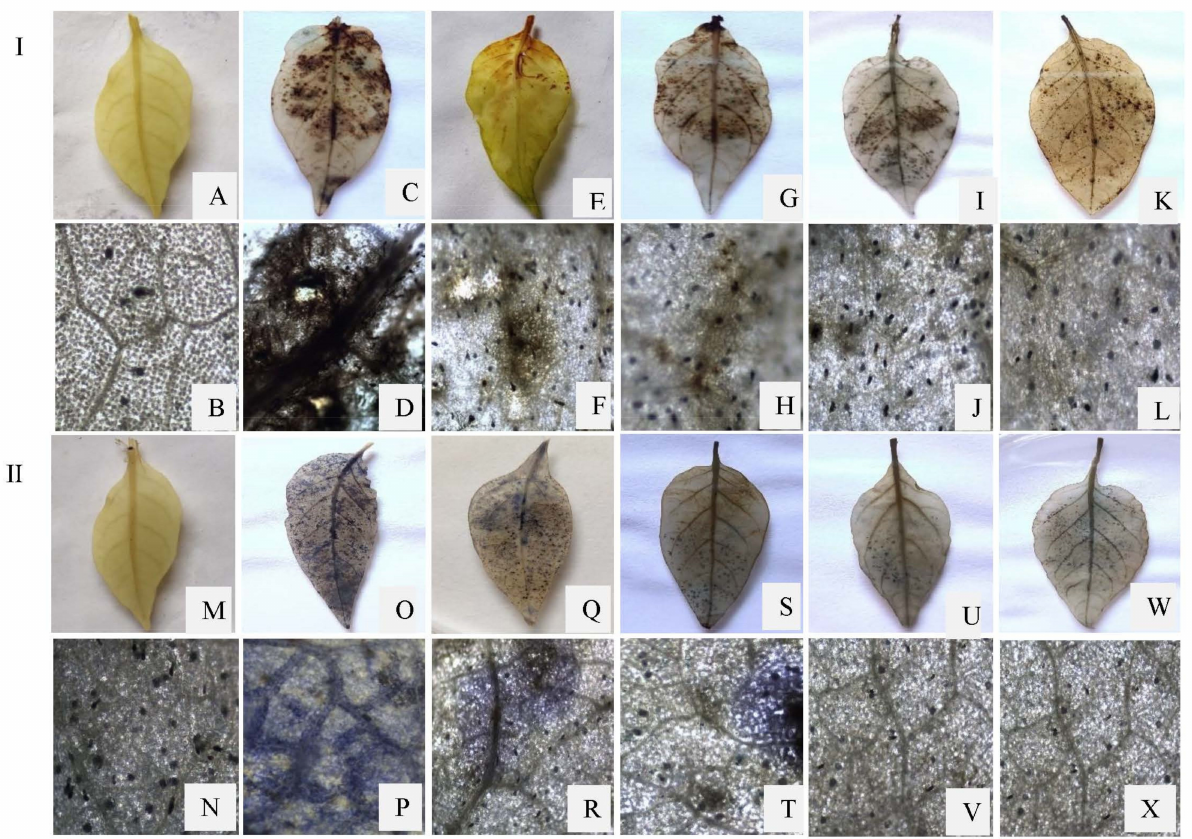
Figure 15. ( I ) Accumulation of H 2 O 2 in chilli leaves as visualized by 3,3 (cid:48) -diaminobenzidine staining at 48 hpi. ( A , B ) Untreated and unchallenged (control); ( C , D ) challenged with a pathogen; ( E , F ) Pre-treated with P. dendritiformis; ( G , H ) Pre-treated with T. asperellum ; ( I , J ) Pre-treated with T. harzianum ; ( K , L ) Pre-treated with T. asperellum + T. harzianum . ( II ) Superoxide anion production in chilli leaves as visualized by nitroblue tetrazolium staining at 48 hpi. ( M , N ) Untreated and unchallenged (control); ( O , P ) challenged with a pathogen; ( Q , R ) Pre-treated with P. dendritiformis ; ( S , T ) Pre-treated with T. asperellum ; ( U , V ) Pre-treated with T. harzianum ; ( W , X ) Pre-treated with T. asperellum + T. harzianum